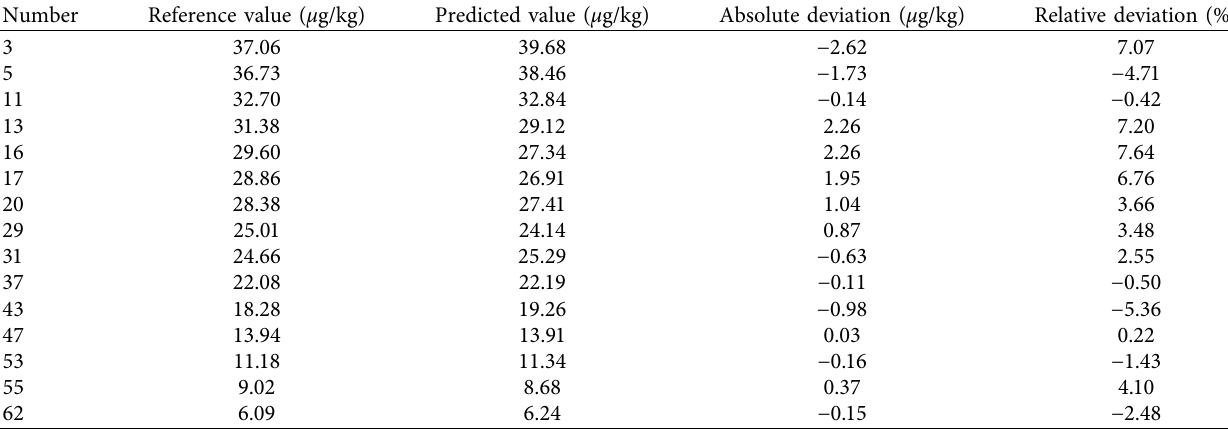
Table 4: The results of external verification of the quantitative